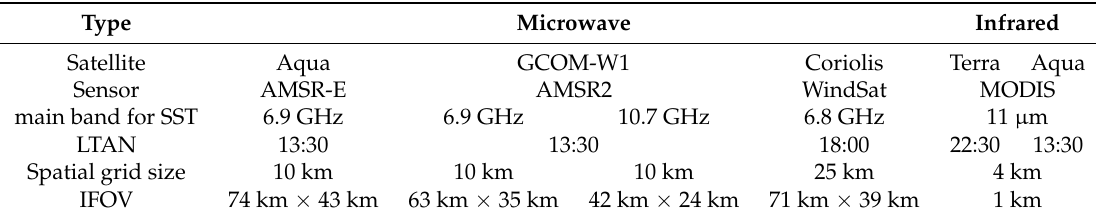
Table 1. List of source SST data used in the product. LTAN: local equatorial crossing time on the ascending node; IFOV: instantaneous field of view (cross-track × along-track for microwave sensors). Note that the spatial grid size for the standard AMSR-E mapped data (Level 3) is 25 km. The 10-km gridded data from the AMSR-E were prepared for this analysis. GCOM-W1, Global Change Observation Mission-Water